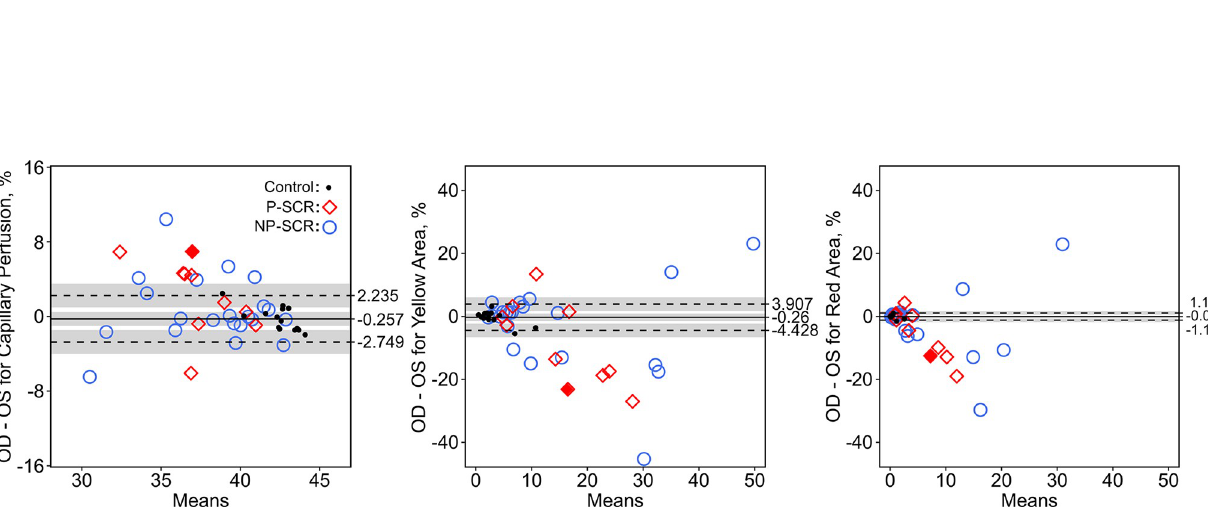
PLOS ONE | https://doi.org/10.1371/journal.pone.0234151 June 10,